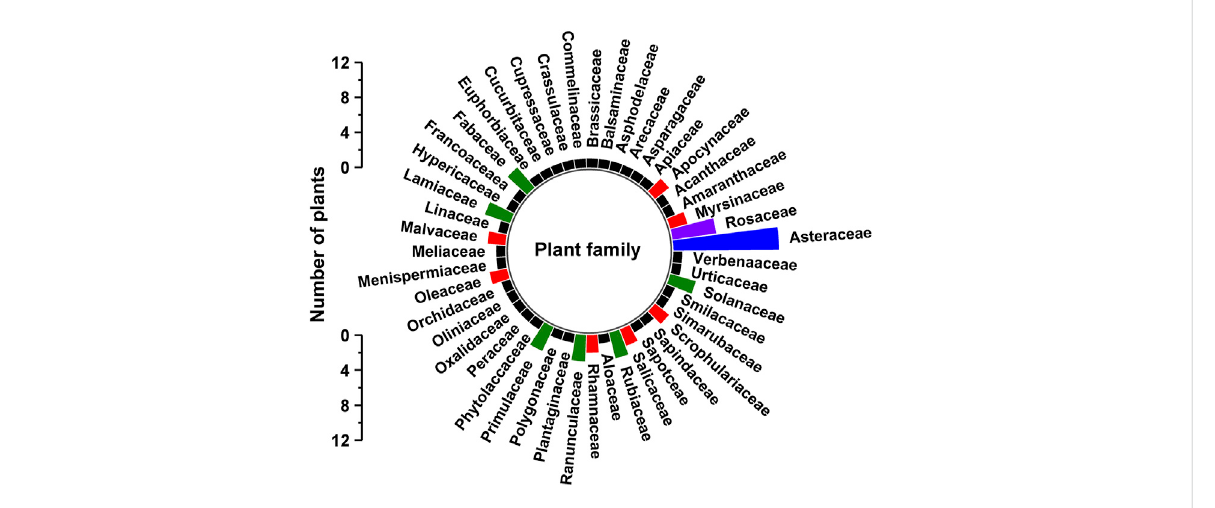
FIGURE 2 PlantfamiliesusedinGulleleBotanicalGarden.The fi guredepictsthenumberofdifferentplantfamiliesusedbythetraditionalhealersatGullele botanical for preparing the traditional